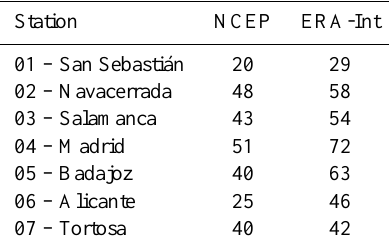
Table 4. Percentage of correct extreme fire danger events (above FWI90) given by the reanalysis – computed as the probability (in %) that an event is extreme for observations, given that it is extreme in the reanalysis. Station codes according to Table